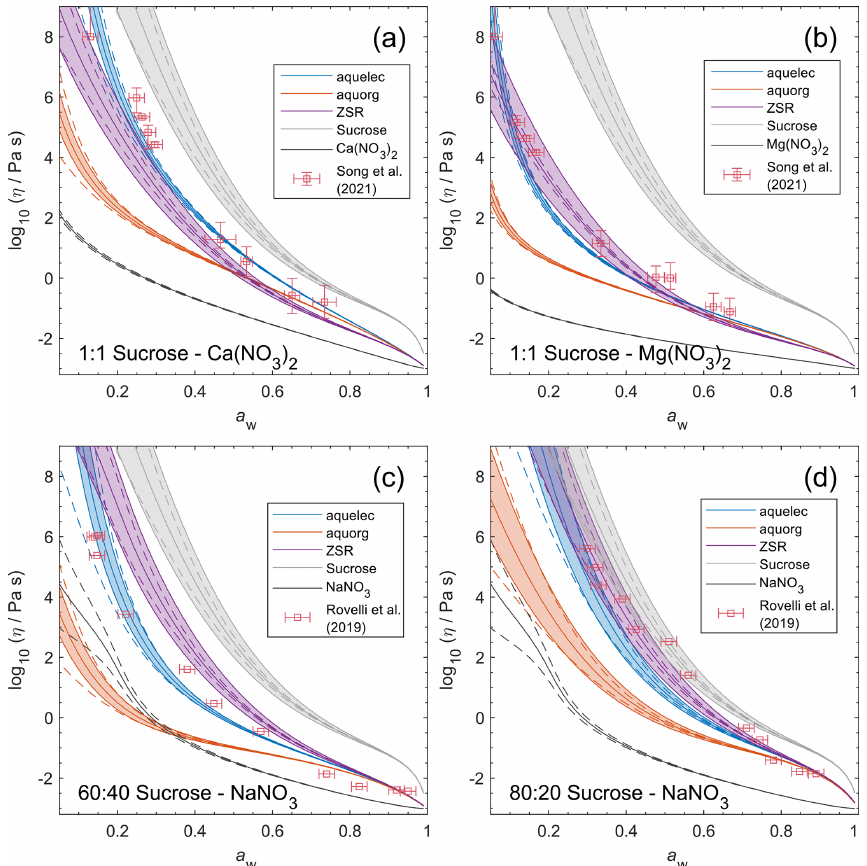
Figure 11. Viscosity predictions for aerosol surrogate mixtures containing sucrose and nitrate salts at varying water activity, a w (RH), with a prescribed organic-to-inorganic dry mass ratio (OIR). Three mixing models – aquelec, aquorg, and ZSR – are shown alongside the viscosity measurements. Model sensitivity, defined by the impact of a ± 2% change in aerosol water content, is shown by the dashed curves. Shaded regions show the potential viscosity prediction error introduced by a ± 5% error in the glass transition temperature of sucrose. AIOMFAC- VISC predictions are also included for the binary aqueous sucrose and aqueous nitrate salt systems, which correspond to the organic and inorganic subsystems used in each mixing model (see Sect.